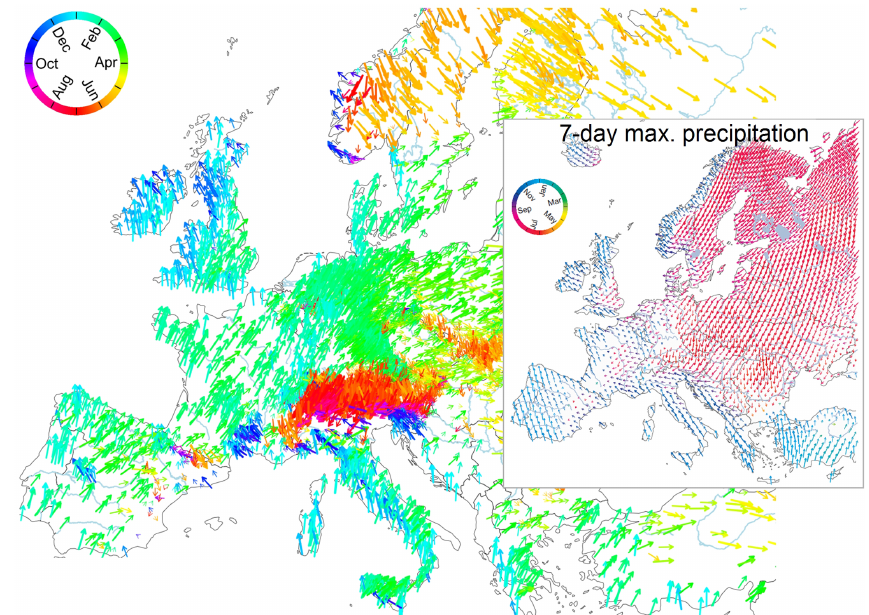
Figure 15. Average timing of floods within the year to understand changes in flood hazards. Blue arrows pointing upwards indicate winter floods, red arrows show downward summer floods. Based on data from 4062 stations, 1960–2010. Inset image shows a similar plot, but for 7d maximum annual precipitation based on the E-Obs data set. The flood seasonality differs significantly from that of precipitation, which is because of the seasonal interplay of soil moisture, snow and extreme precipitation (Blöschl et al.,